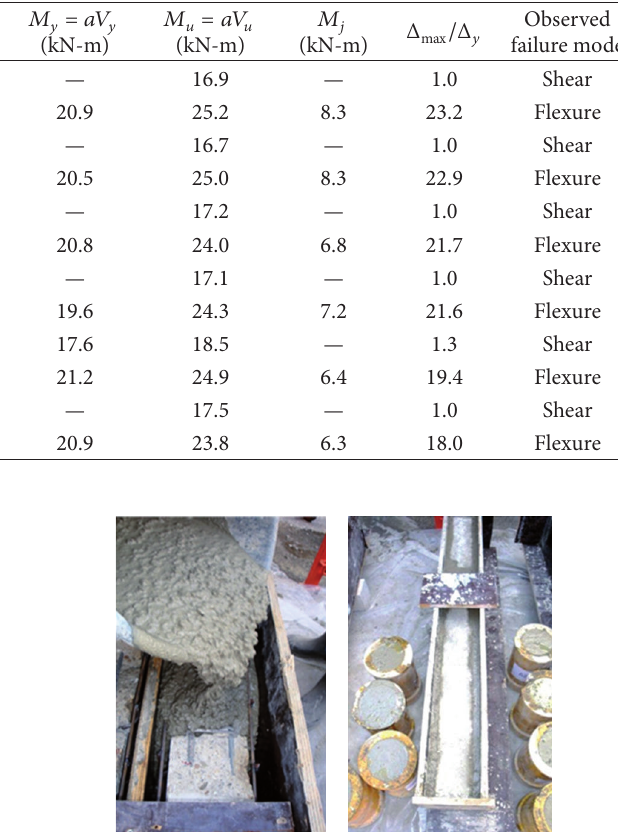
F 4: Formwork of the jacket and SCC pouring.